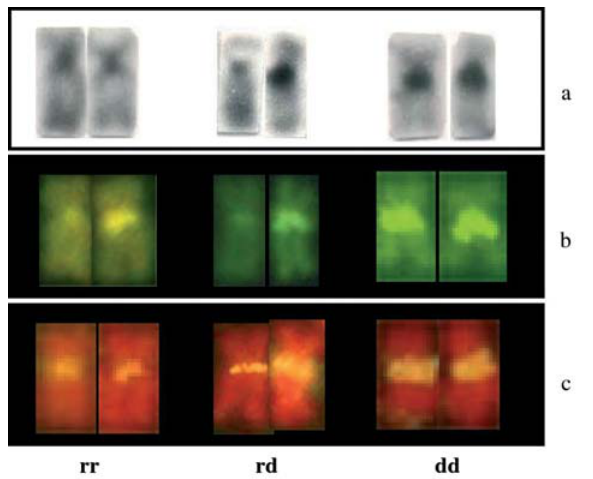
Figure 7 - Chromosomes of Hoplias malabaricus from the Iguaçu River, showing the associated heterochromatin/NOR polymorphism on pair n. 16: (a) C-banding, (b) chromomycin A 3 staining, and (c) 18S rDNA FISH. rr = two reduced bands; rd = one reduced plus one duplicated band; dd = two duplicated